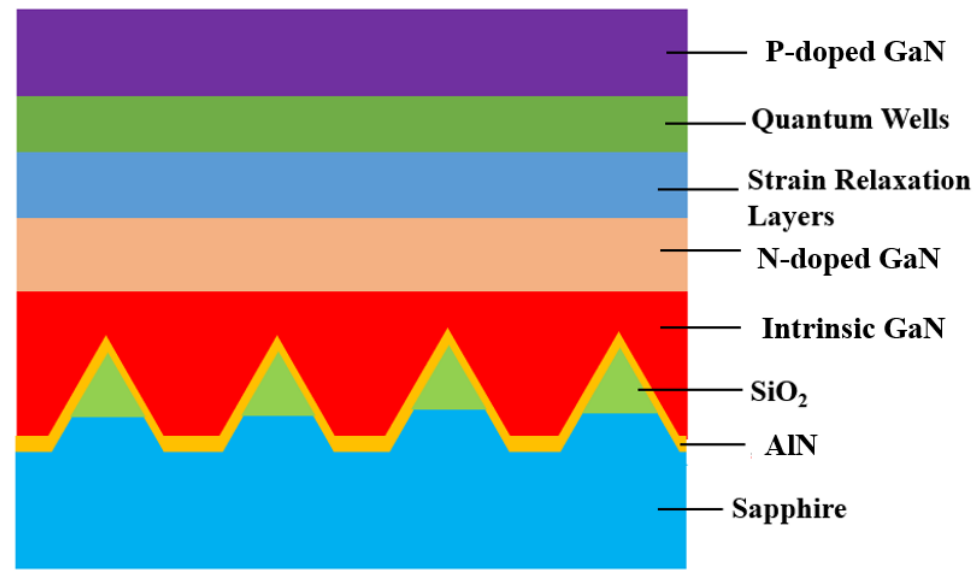
Figure 3. The complete epitaxial structure of LED. The illustration only reveals the locations. The size of each part does not represent the real proportion.